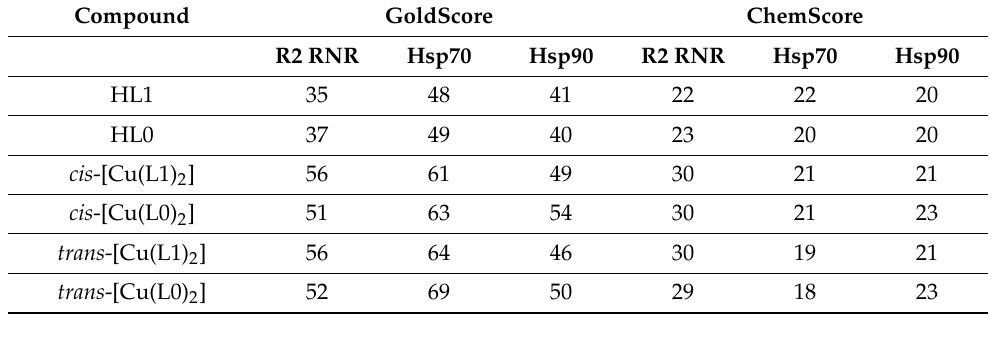
Table 3. Values of the GoldScore and ChemScore functions for predicted poses of studied compounds within active sites of the targets R2 RNR, Hsp70, and Hsp90.